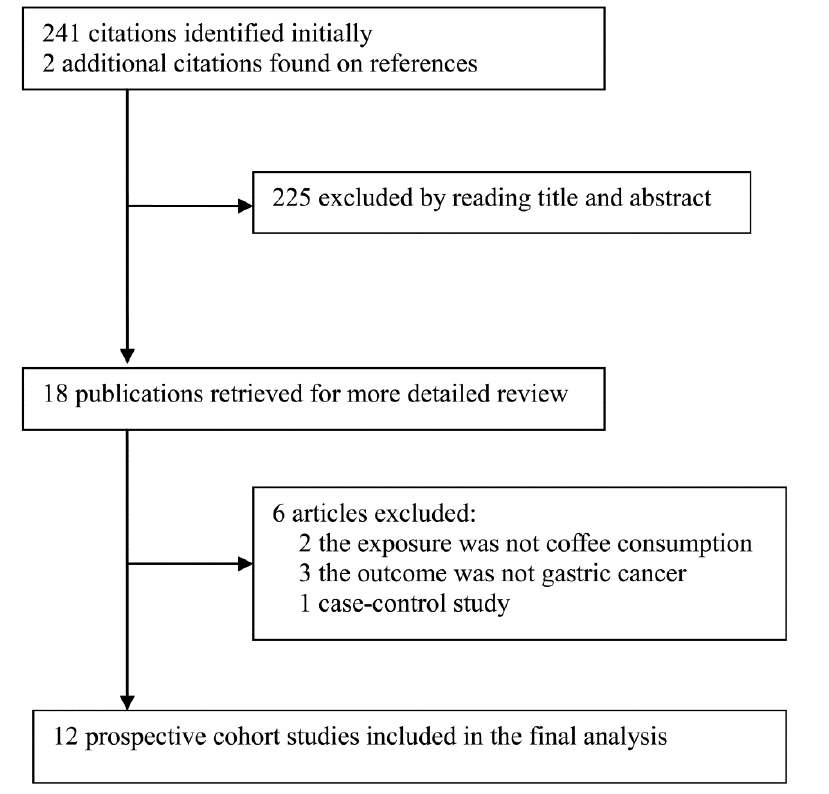
Figure 1. Flow chart showing process of literature